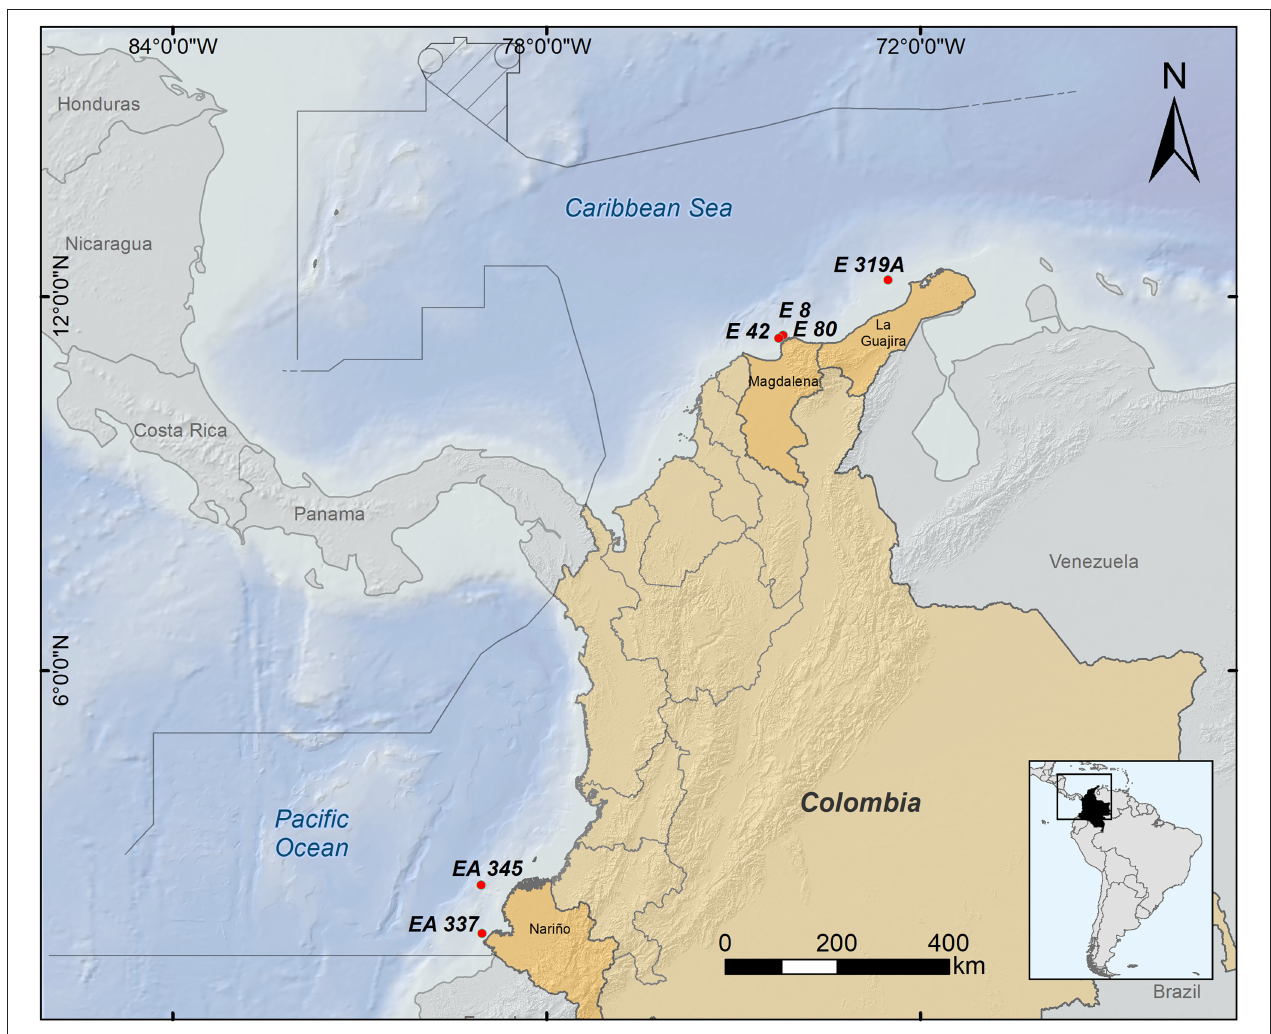
FIGURE 1 | Sampling sites in the Colombian Pacific and Caribbean Sea where samples of Callogorgia spp. in association with brittle stars were collected. Collections were made in different stations (red points) during different INVEMAR expeditions: Macrofauna 1 (Magdalena sites), ICP (La Guajira sites), and Tumaco Offshore (Pacific sites, Nariño). Stations names are the same used in each